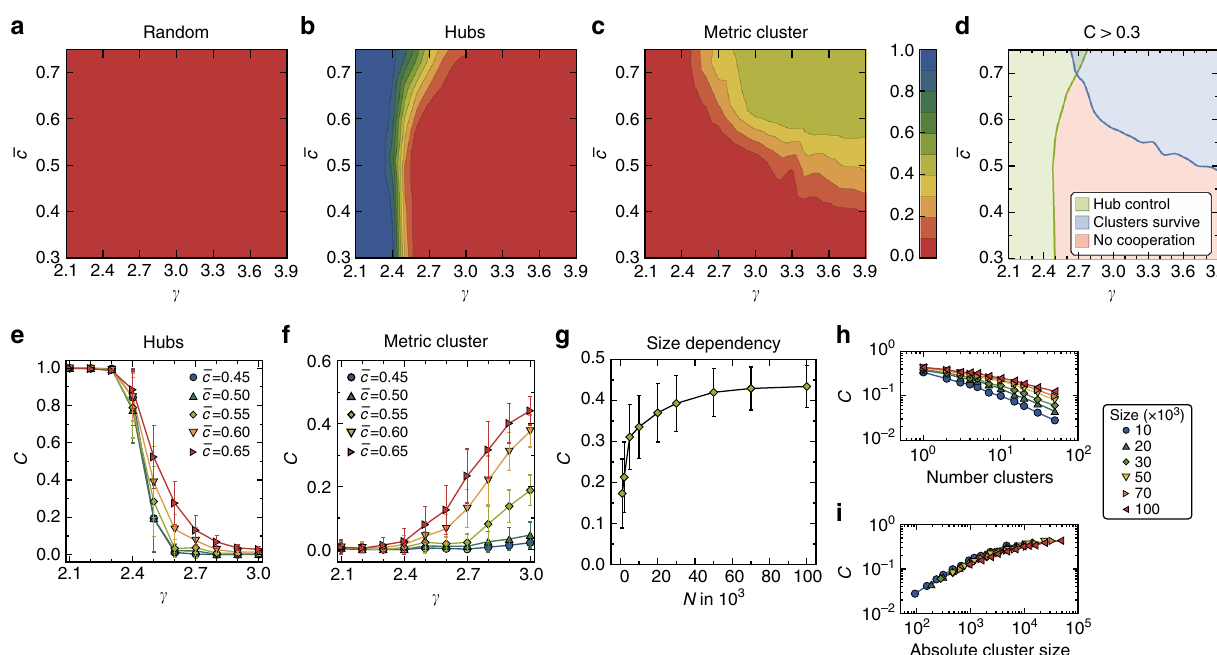
Fig. 5 The impact of heterogeneity and clustering. a – c Final (after 2 × 10 5 update steps) density of cooperators (color coded) for the prisoner ’ s dilemma game ( T = 1.5 and S = − 0.5) averaged over 50 realizations as a function of the degree distribution power-law exponent γ and mean local clustering c . Networks have N = 2 × 10 4 nodes and a mean degree k h i ≈ 6. The initial density of cooperators is always c (0) = 0.5. a Randomly assigned initial cooperators. b Hubs are assigned as initial cooperators with a probability p ∝ k . c Initial cooperators are localized in the angular space. d Regions where the fi nal cooperation exceeds a threshold value of 0.3 for the cases presented in a – c . e Final cooperation as a function of the network heterogeneity for different values of c starting with preferential hub assignment, representing different cuts through b . Error bars denote one standard deviation from top to bottom. f Final cooperation as a function of the network heterogeneity for different values of c starting with cooperators assigned into a metric cluster, representing different cuts through c . Error bars denote one standard deviation from top to bottom. g Final cooperation density as a function of the network size for synthetic networks with power-law exponent γ = 2.9, c ¼ 0 : 6, and mean degree k h i ≈ 6. Error bars denote one standard deviation from top to bottom. h Final cooperation for different network sizes (see legend) and the same parameters as before. Initial cooperators ( c (0) = 0.5) are assigned into different numbers of disjoint metric clusters, whose number is plotted on the x -axis. i The same as h , but on the x -axis the resulting absolute size of each cluster is shown, given by the number of nodes divided by twice the number of cooperating